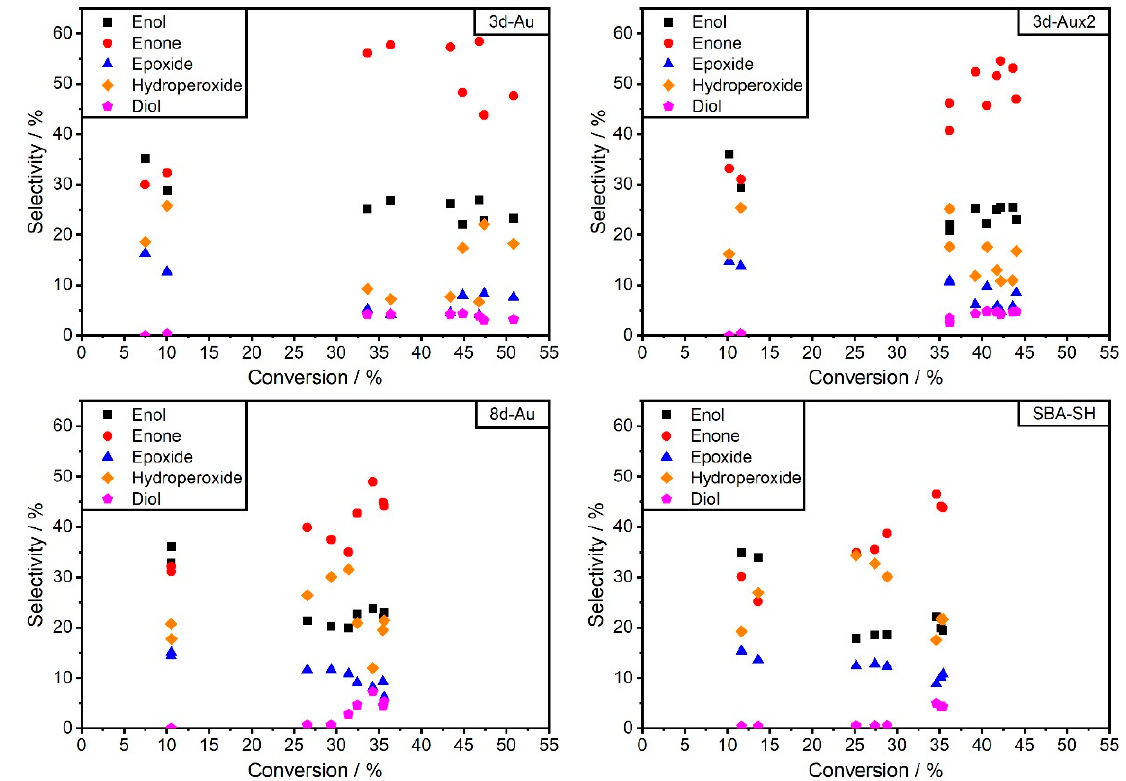
Figure 8. Selectivity as a function of